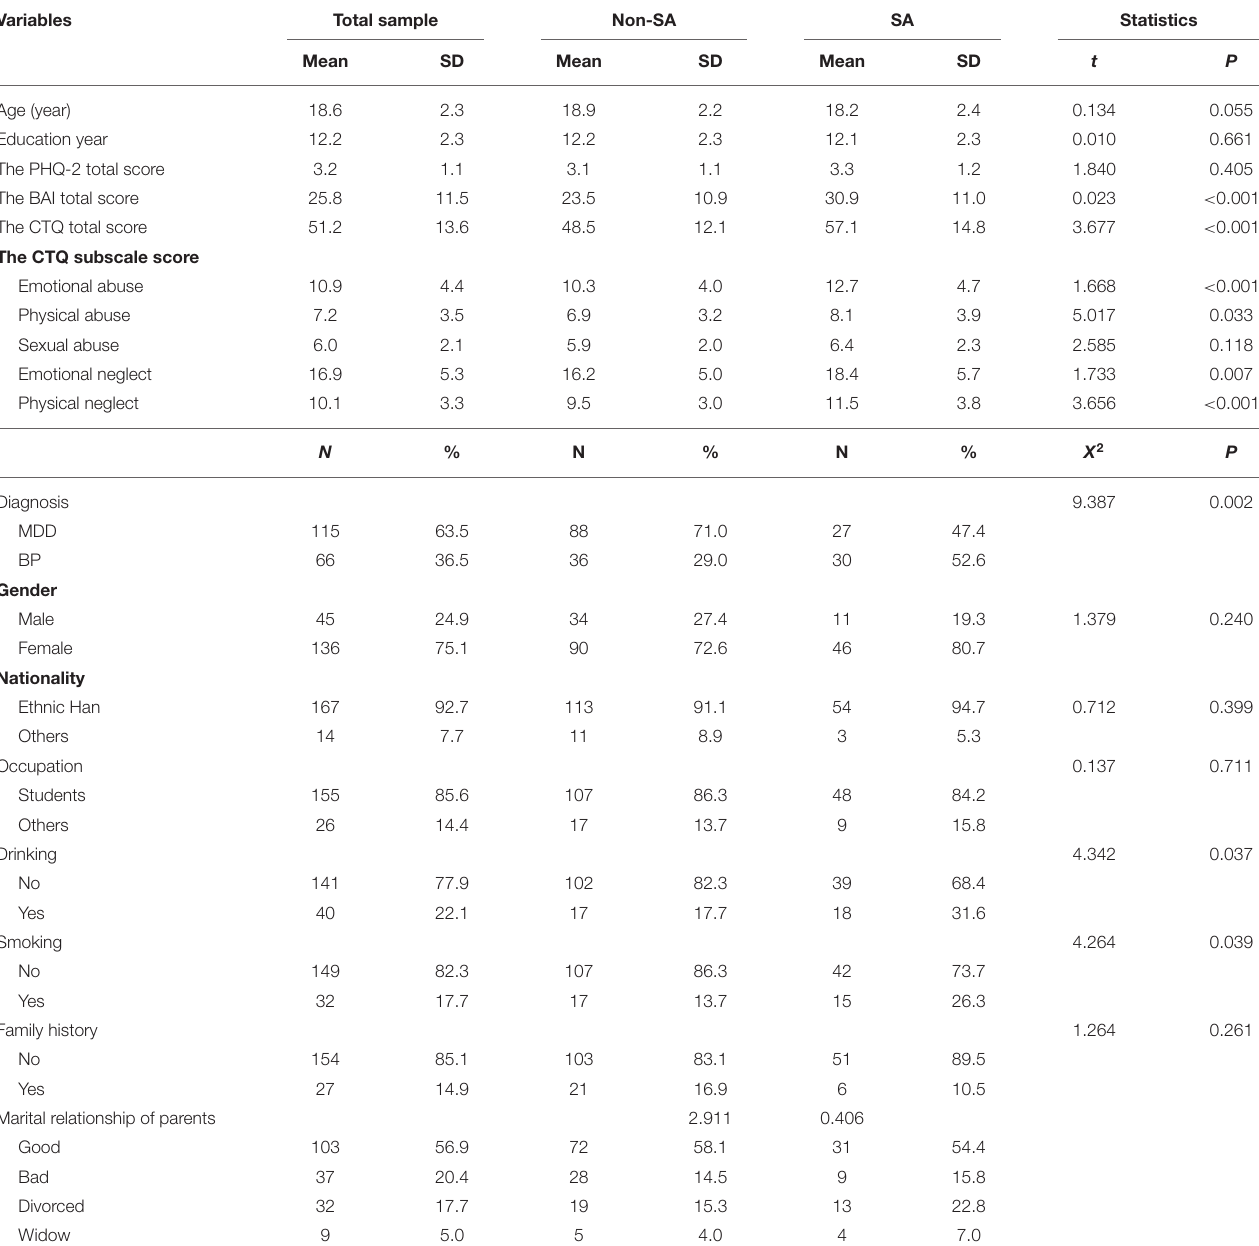
TABLE 1 | Sociodemographic and clinical characteristics among adolescents and young adults with first depressive episode.